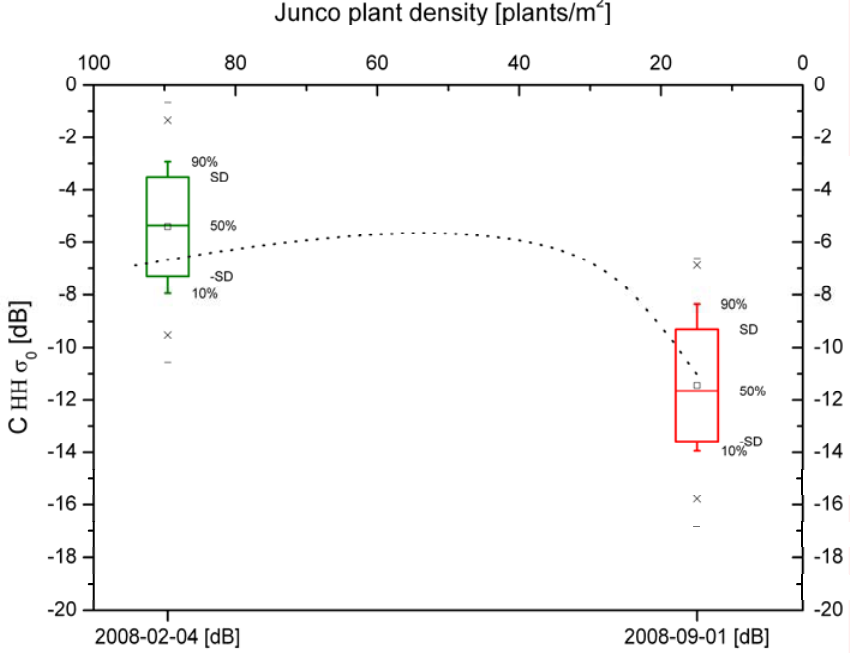
Figure 6. Box plots of C HH σ 0 values of junco marsh sites in normal condition (green) and burned condition (red) superimposed with a model simulation of the HH σ 0 values of the junco marsh as a function of JPD. The input model parameters used in this simulation are summarized in Table